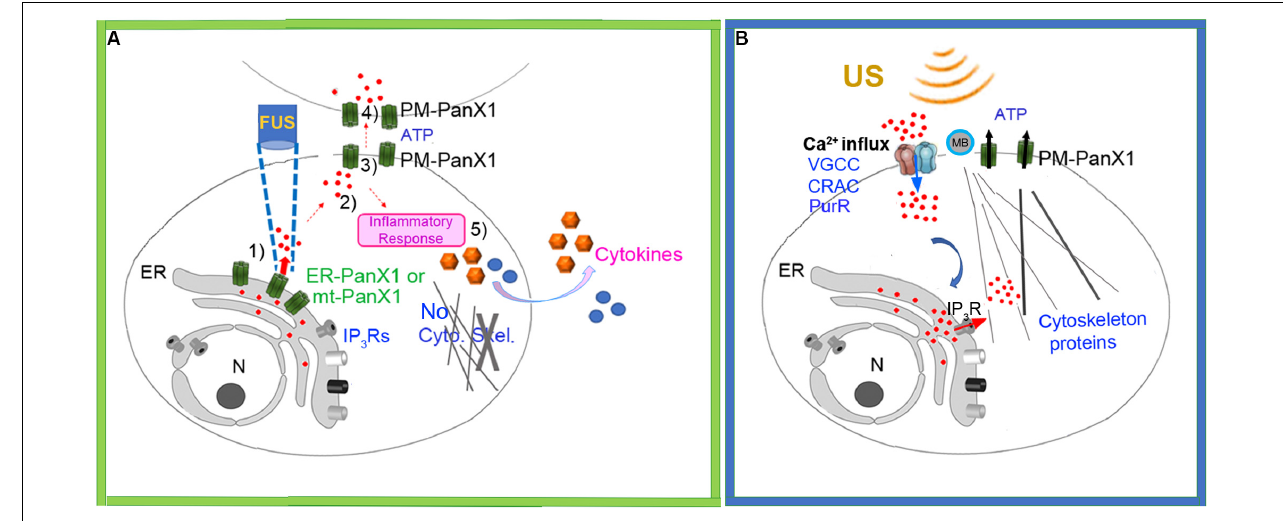
FIGURE 9 | (A) Schematic of new working model FUS-dependent response mechanisms in PC-3 invasive cancer cells. (1) FUS stimulation activates ER localized mechanosensitive PANX1 resulting in internal Ca 2 + release from ER stores. (2) This cytoplasmic Ca 2 + signal stimulates ATP release through PANX1 PM channels. (3) The released ATP acts on purineregic receptors, many in adjacent cells. (4) This results in a propagating extracellular Ca 2 + wave which spreads through the cell population possibly via PM PANX1 or opening of PM Ca 2 + channels. (5) FUS stimulation also results in secretion of cytokines/chemokines. (B) Schematic of currently accepted working model based largely on conventional US stimulation with no proposed role for internal ER Ca 2 + release but rather a link to US energy transduction to ER mediated by IP 3 R. MB,